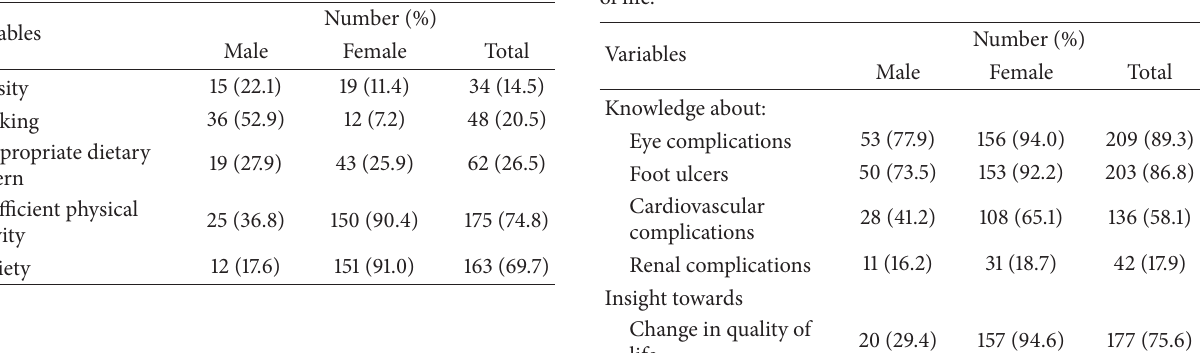
Table 4: Prevalence of behavioral and nonbehavioral risk factors of type 2 diabetes related complications amongst the studied patients.